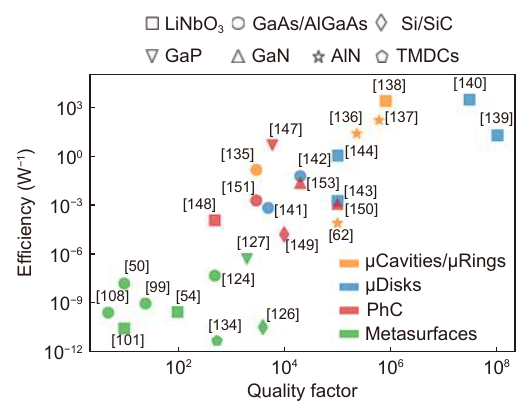
Fig. 6 | SHG efficiency vs. Q-factor of the dominant FF mode for different resonant devices (markers’ color) and materials (mark- ers’